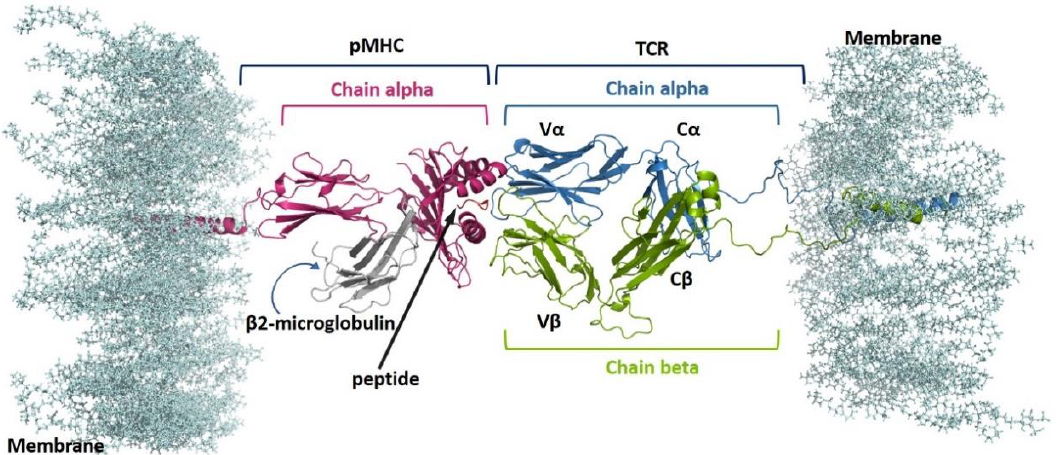
Figure 1. Model of one of the pMHC-TCR simulated complexes. The different regions are labelled: Vα/Vβ and Cα/Cβ refer to the TCR Variable regions (alpha/beta) and TCR Constant regions (alpha/beta), respectively.